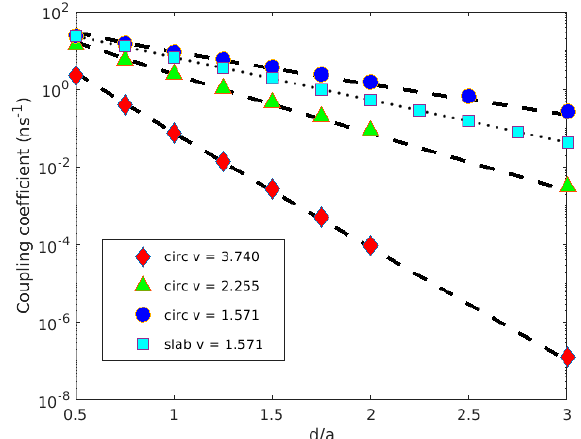
Figure 2. Variation of coupling rate with d / a for pairs of circular cylindrical guides with three values of v and for a slab guide with v = 1.571. Symbols (circles, squares, triangles, diamonds) are calculated from normal-mode theory; dashed and dotted lines are fitted from analytic results given in the text.